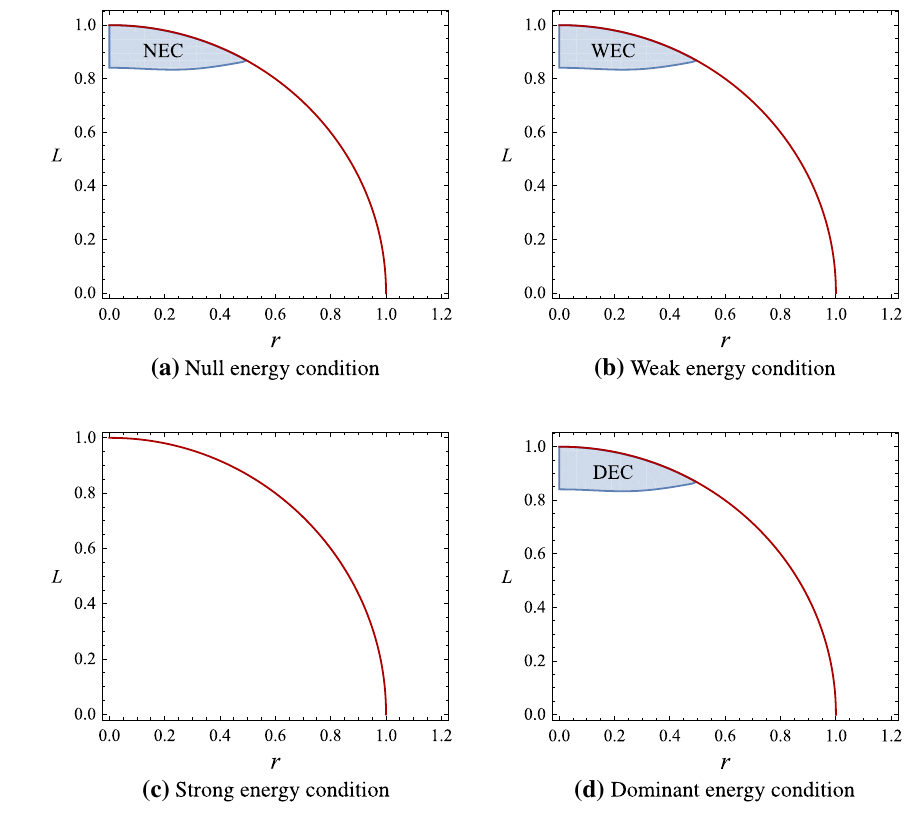
Fig. 6 The blue shadows show the valid domains of NEC, WEC, and DEC for the case of N = 1 / 2, where no valid domains exist for the SEC. The red curves are horizons in